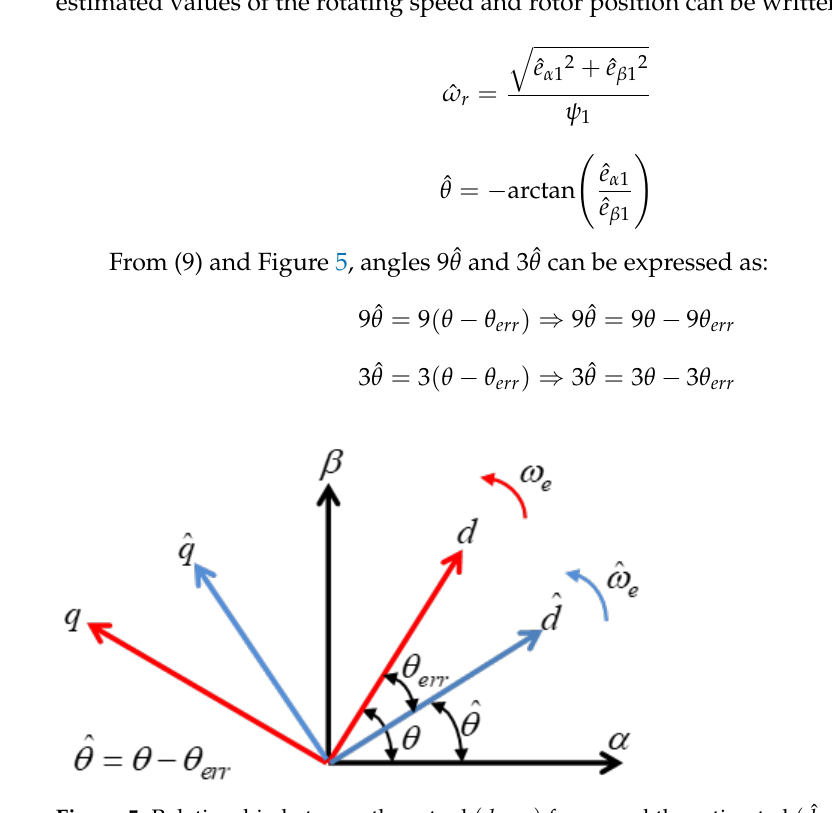
Figure 5. Relationship between the actual ( d − q ) frame and the estimated ( ˆ d − ˆ q )